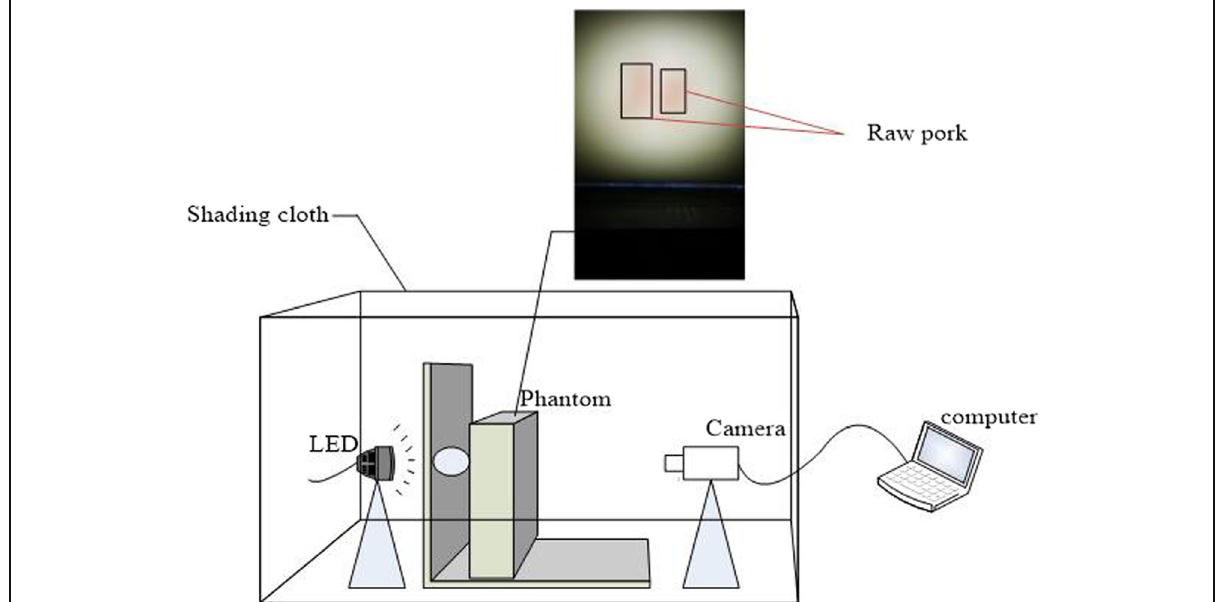
Fig. 2 The schematic diagram of the experiment system